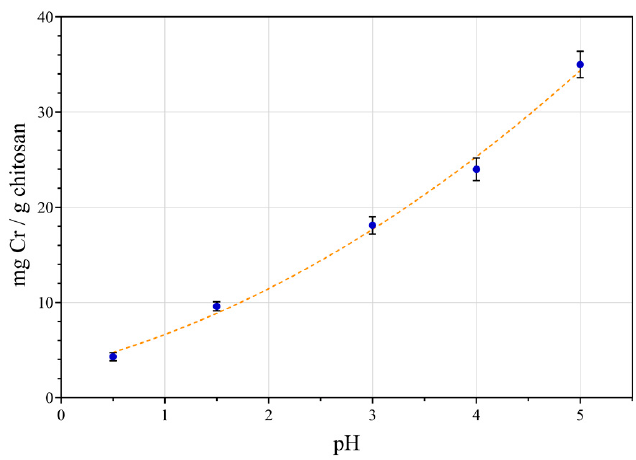
Figure 3. Effect of pH (initial value) on chromium(III) adsorption on chitosan (C 0 = 500 mg L − 1 ). Table 2. pH variation vs. Cr(III) concentration (pH in = 3.8).